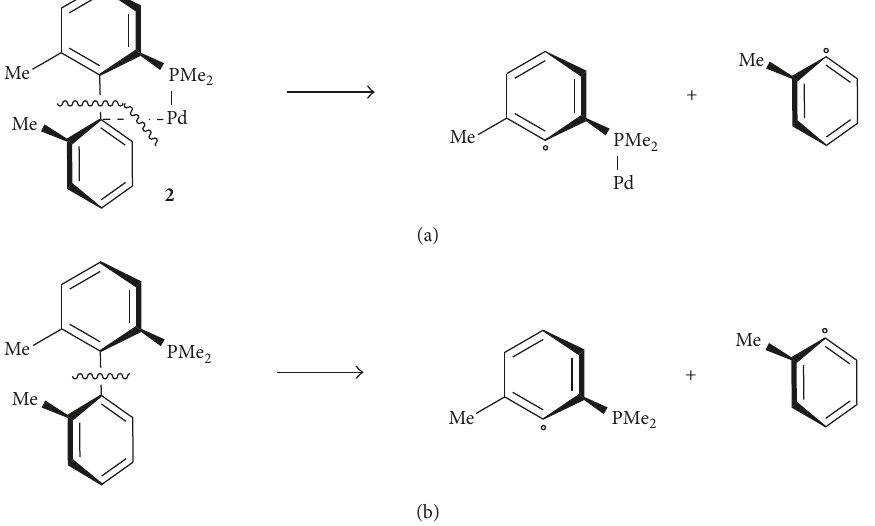
Figure 3: “Homolytic dissociation” of C,P- complex 2 (a) and respective phosphine ligand